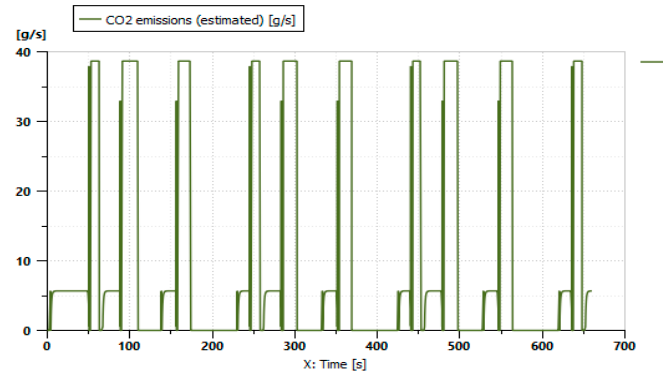
Figure 22. The variation in the CO 2 release.